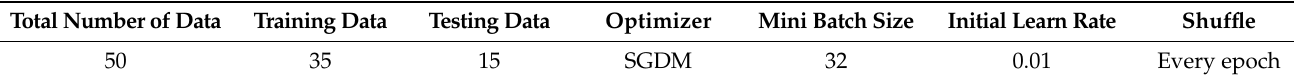
Table 7. CNN training